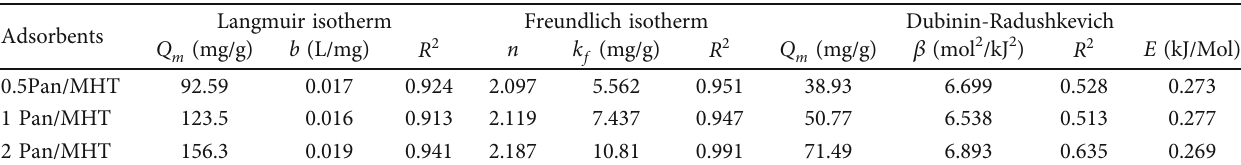
Figure 13: Adsorption isotherms of MO on Pan/MHT composites with Langmuir isotherm model (a), Freundlich isotherm model (b), and Dubinin-Radushkevich isotherm model (c). Table 3: Fitting parameters of adsorption isotherms for MO on Pan/MHT